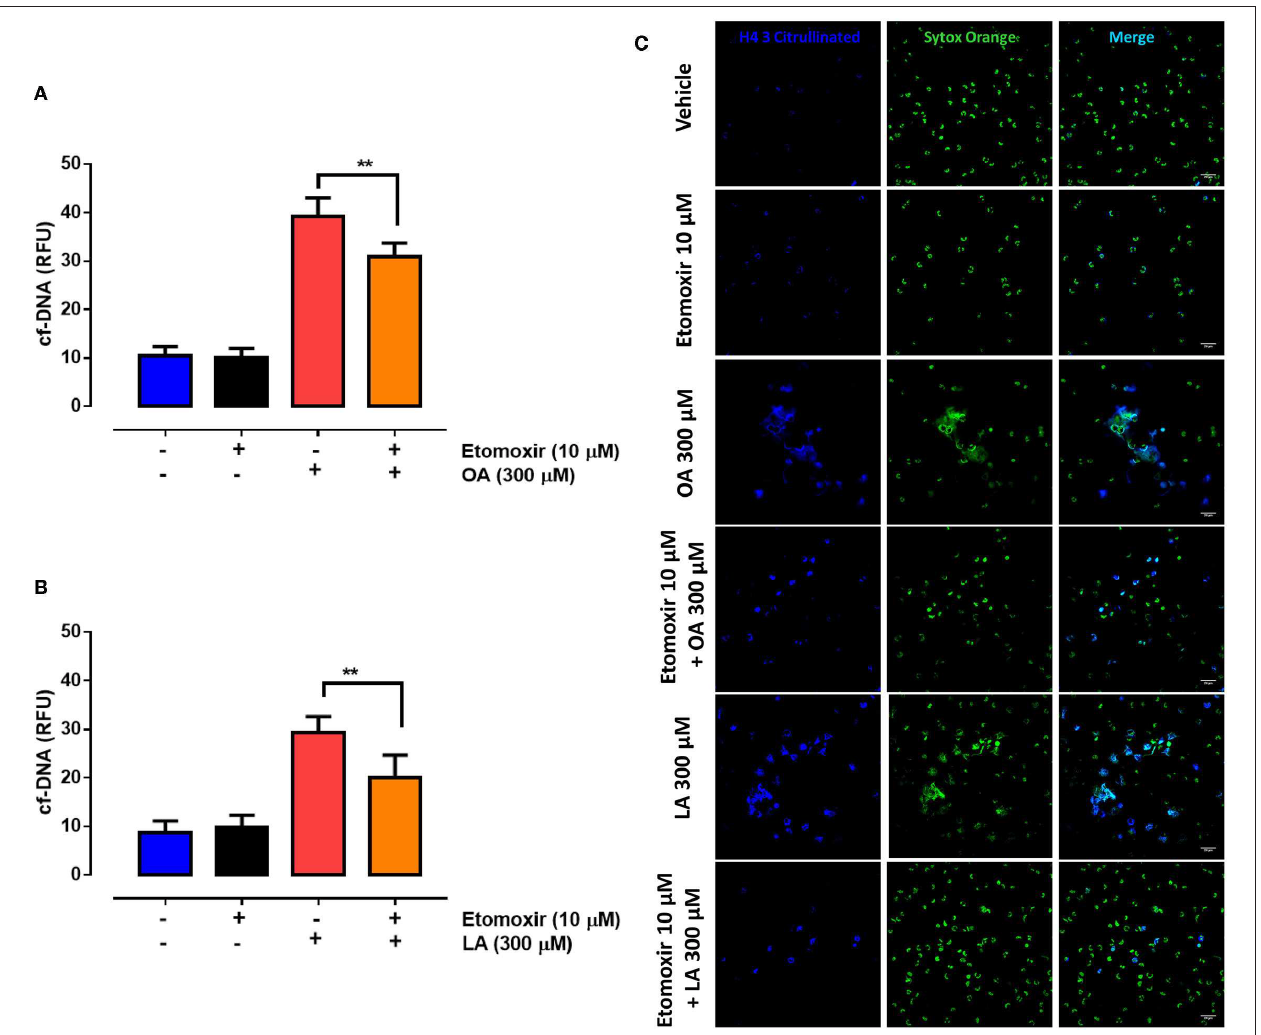
FIGURE 7 | Etomoxir partially blocks non-esterified fatty acid (NEFA)-induced neutrophil extracellular trap (NET) formation. Bar graph (means ± S.E.M.) of cell-free (cf)-DNA of PMN treated with 10 µ M etomoxir for 60min and stimulated with oleic acid (OA) (A) or linoleic acid (LA) (B) . Representative image from four independent experiments of PMN treated with etomoxir and stimulated with OA or LA (C) . n = 4; ** p < 0.01 compared with OA or LA treatment alone.